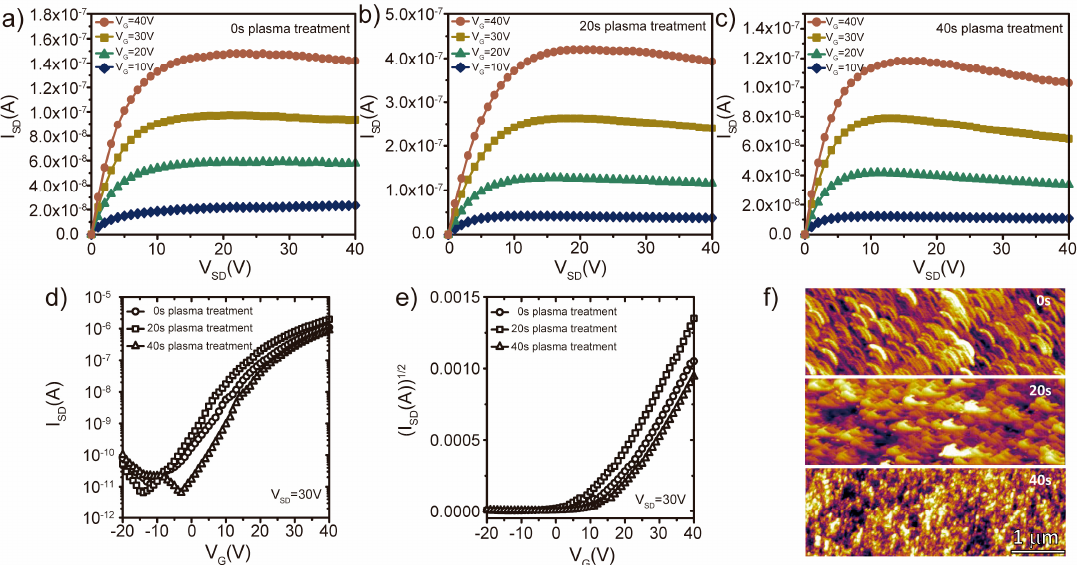
Figure 7. Output characteristics without ( a ) and with 20 s ( b ) and 40 s ( c ) plasma treatment on the surface of the patterned channel layers. ( d , e ) Transfer characteristics of TFTs with different plasma treatments. The channel length, width, and thickness of the above TFTs are about 60 µm, 300 µm, and 30 nm, respectively. ( f ) Atomic force microscope images of the printed InGaZnO channel layer without and with different plasma treatment time.